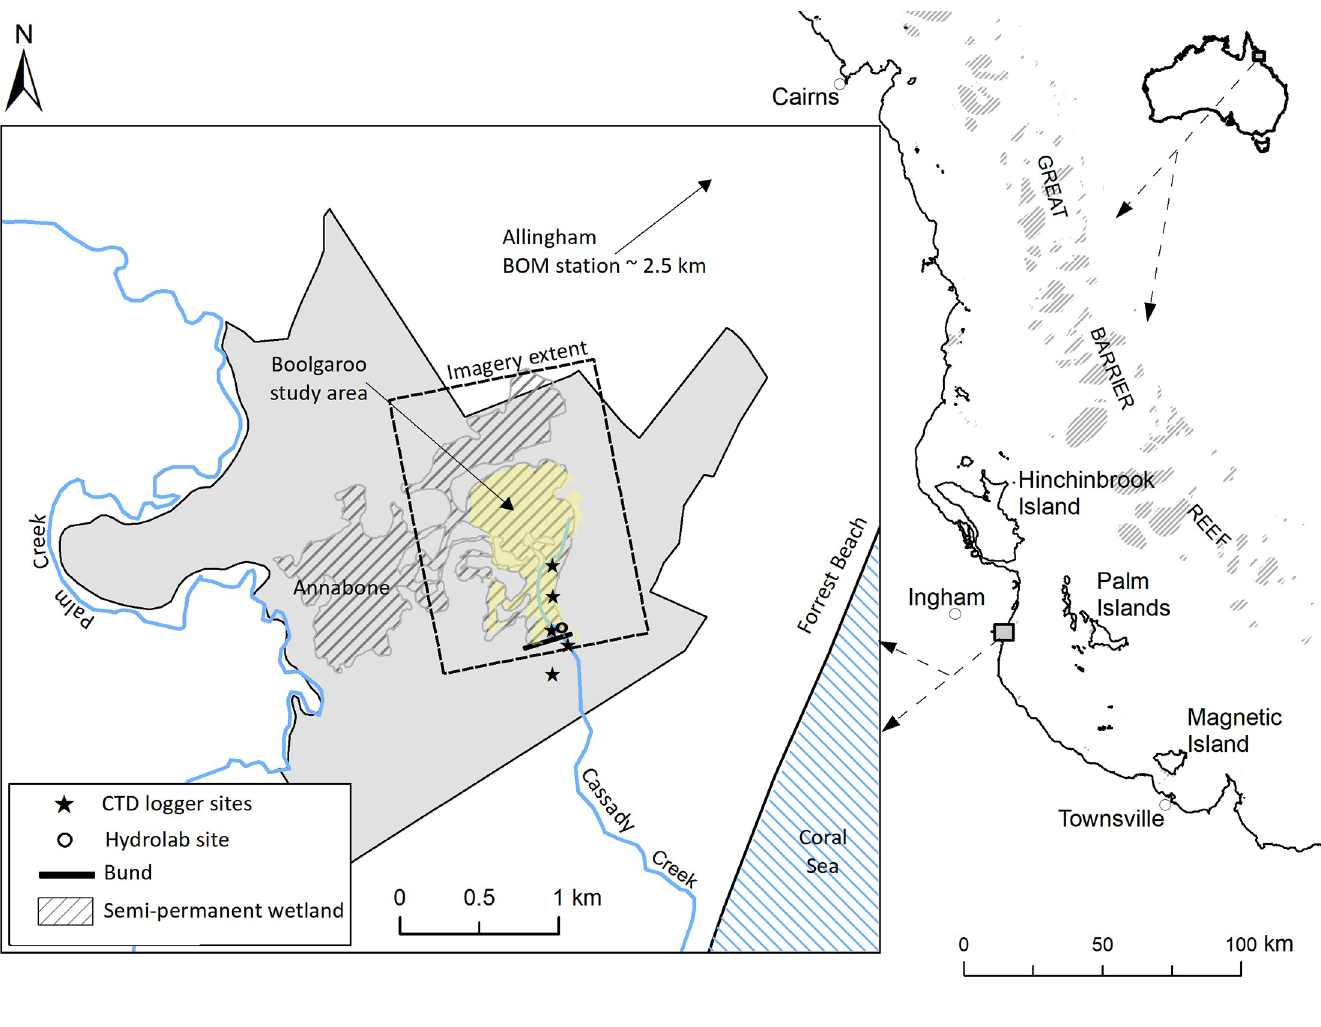
Fig 1. Location of wetlands within Mungalla station in the lower Herbert River catchment, Queensland, Northern Australia. The Mungalla wetlands are hatched in dark grey, the Boolgooroo region of the wetland complex is shown in yellow. Also shown are the locations of the logger sites above and below the earth bund which was removed on 6 th October